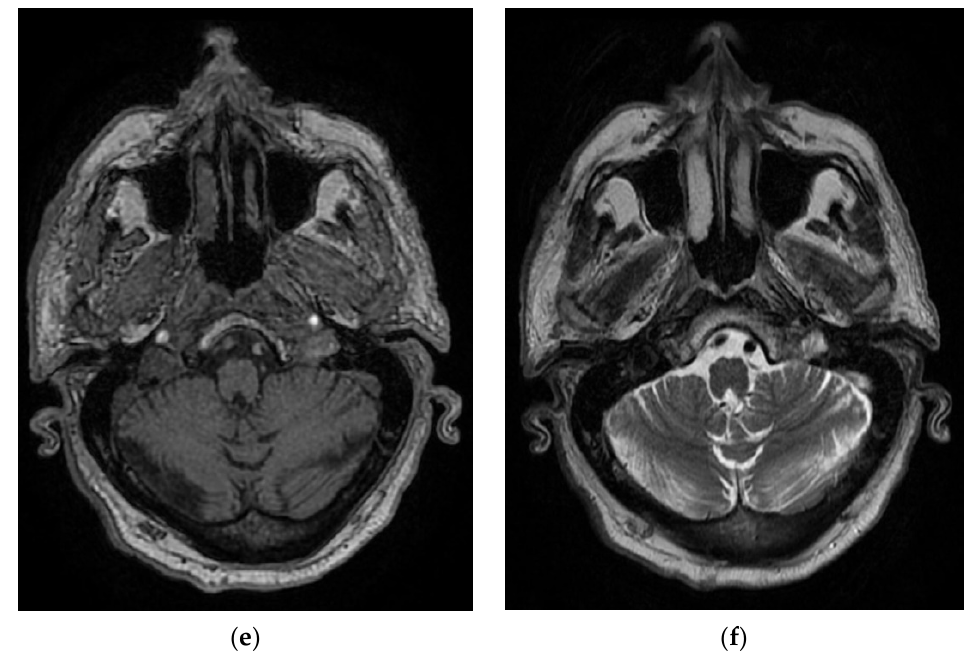
Figure 6. Hyperintense and nonhomogeneous T1 and T2 material, in the Case 6 patient, which partially occupies the transverse sinus ( a , b ) and left sigmoid sinus ( c , d ) towards the jugular bulb ( e , f )–left venous transverse–sigmoid–jugular subacute thrombosis.